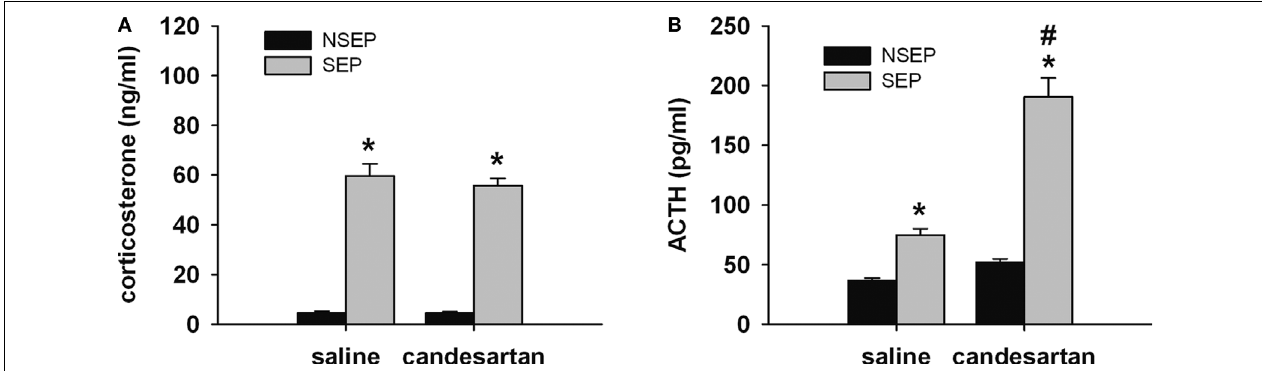
FIGURE 2 | Effects of candesartan treatment in non-separated (NSEP) and separated (SEP) mouse pups on corticosterone (A) and ACTH (B) plasma values. Maternal separation increased corticosterone and ACTH secretion. No effects of candesartan treatment were seen for corticosterone. For